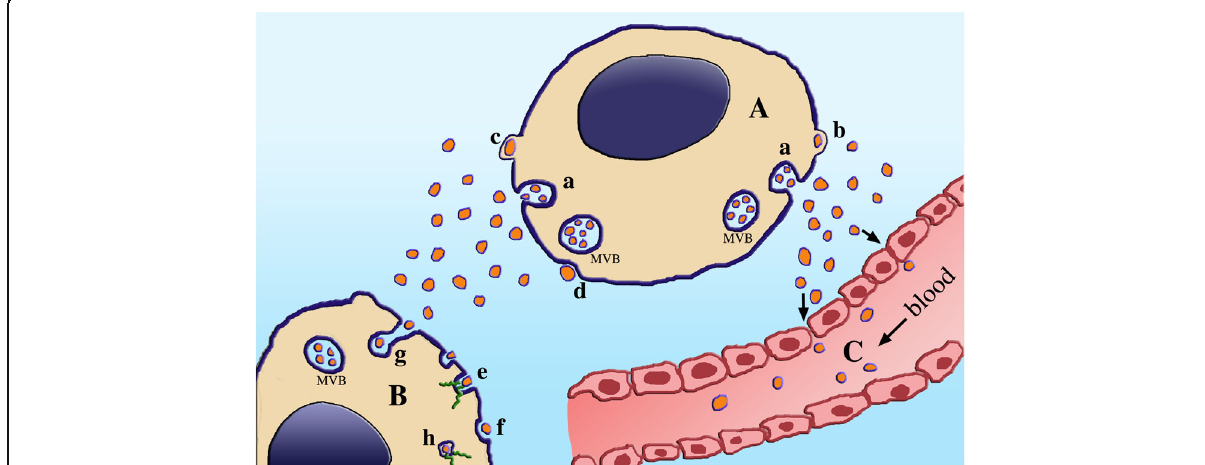
Fig. 2 Secretion of EVs by the cell A, their navigation in the extracellular space, and their uptake by the target cell B and a blood capillary C. Secretion is shown in the upper cell (A, gray color). Exosomes (small, red), previously accumulated within multi-vesicular bodies (MVB) of endocytic nature, are released upon the exocytosis of the latter (a) [1]. Ectosomes are secreted by a completely different process: upon their assembly and growth at the cytosolic surface of peculiar rafts continuous to the plasma membrane (b,c) they are converted into EVs released from the cell surface by pinching off and then shedding of the rafts (d). As it occurs within tissues, the EVs navigating in the extracellular space are addressed to various targets (two in this Figure). The cell to the left (B) receives EVs released from the left side of cell A. Upon their association by receptor binding to the surface of cell B, the EVs disassemble their cargos which are transferred to the cytoplasm along green short lines (e); for other EVs the process is analogous, however it occurs after their endocytic uptake and internalization (g,h). The EVs to the right are taken up into a large blood capillary lumen (C, red pink color), reached upon their transfer first across the blood-brainbarrier (not shown) and then through the junctions between endocytic cells, pointed here by